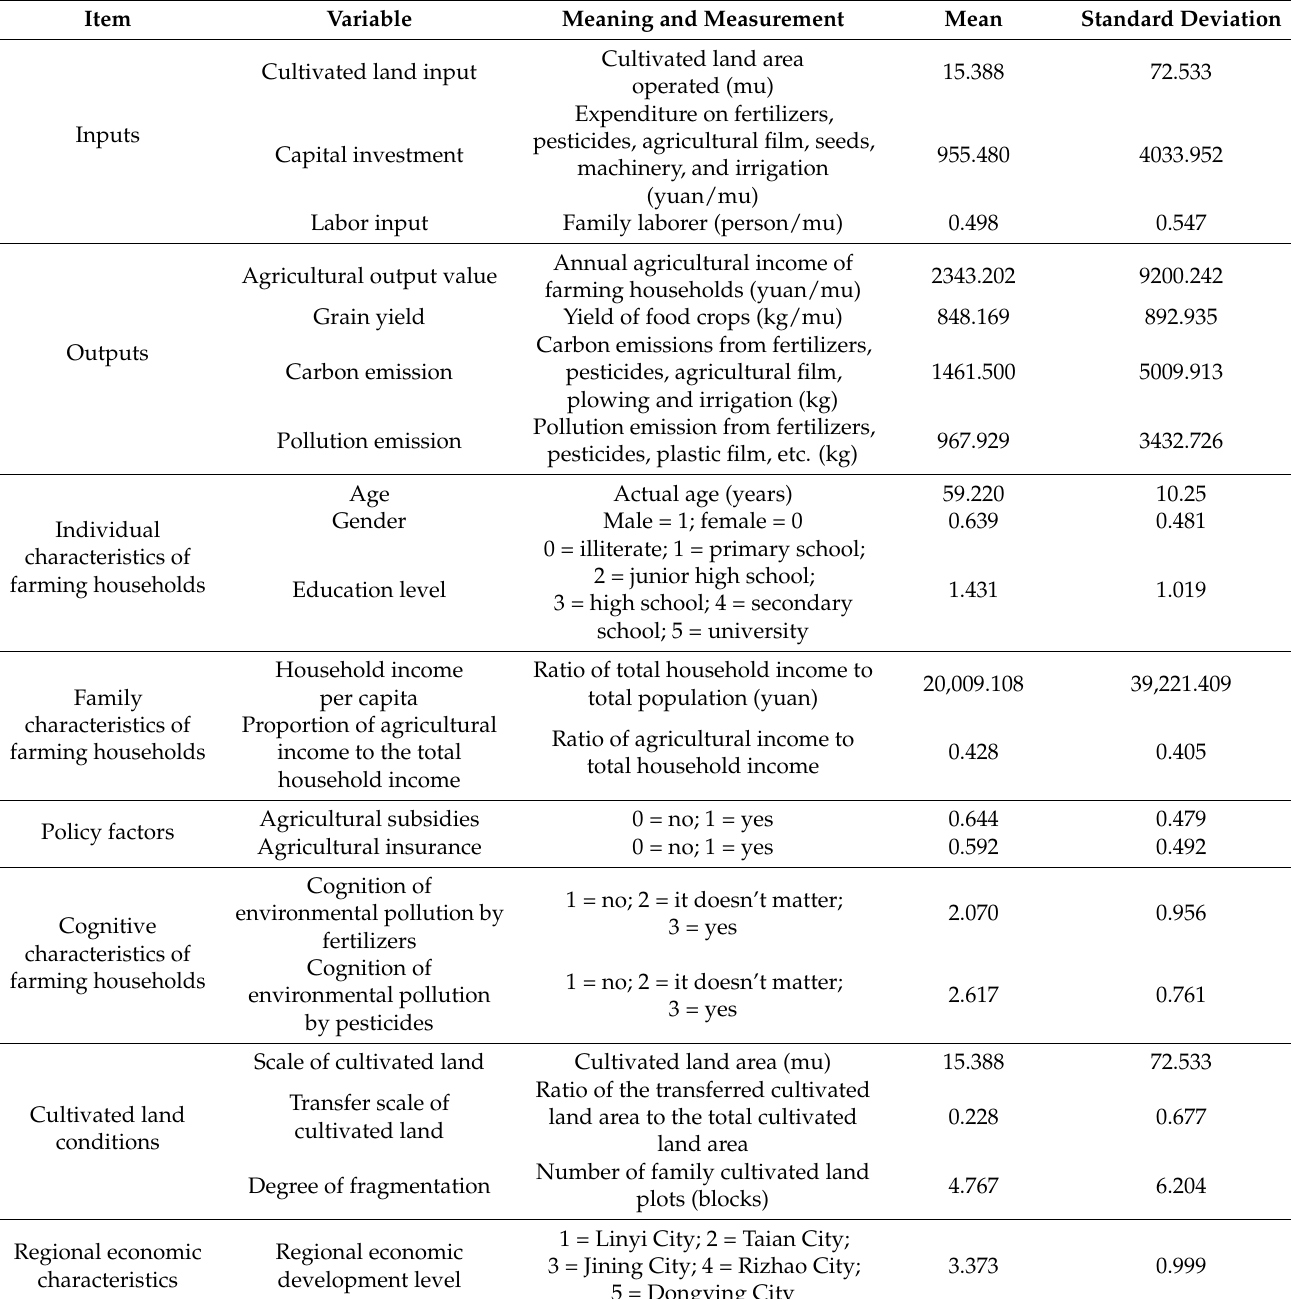
Table 1. Variable definition and descriptive statistics (n =